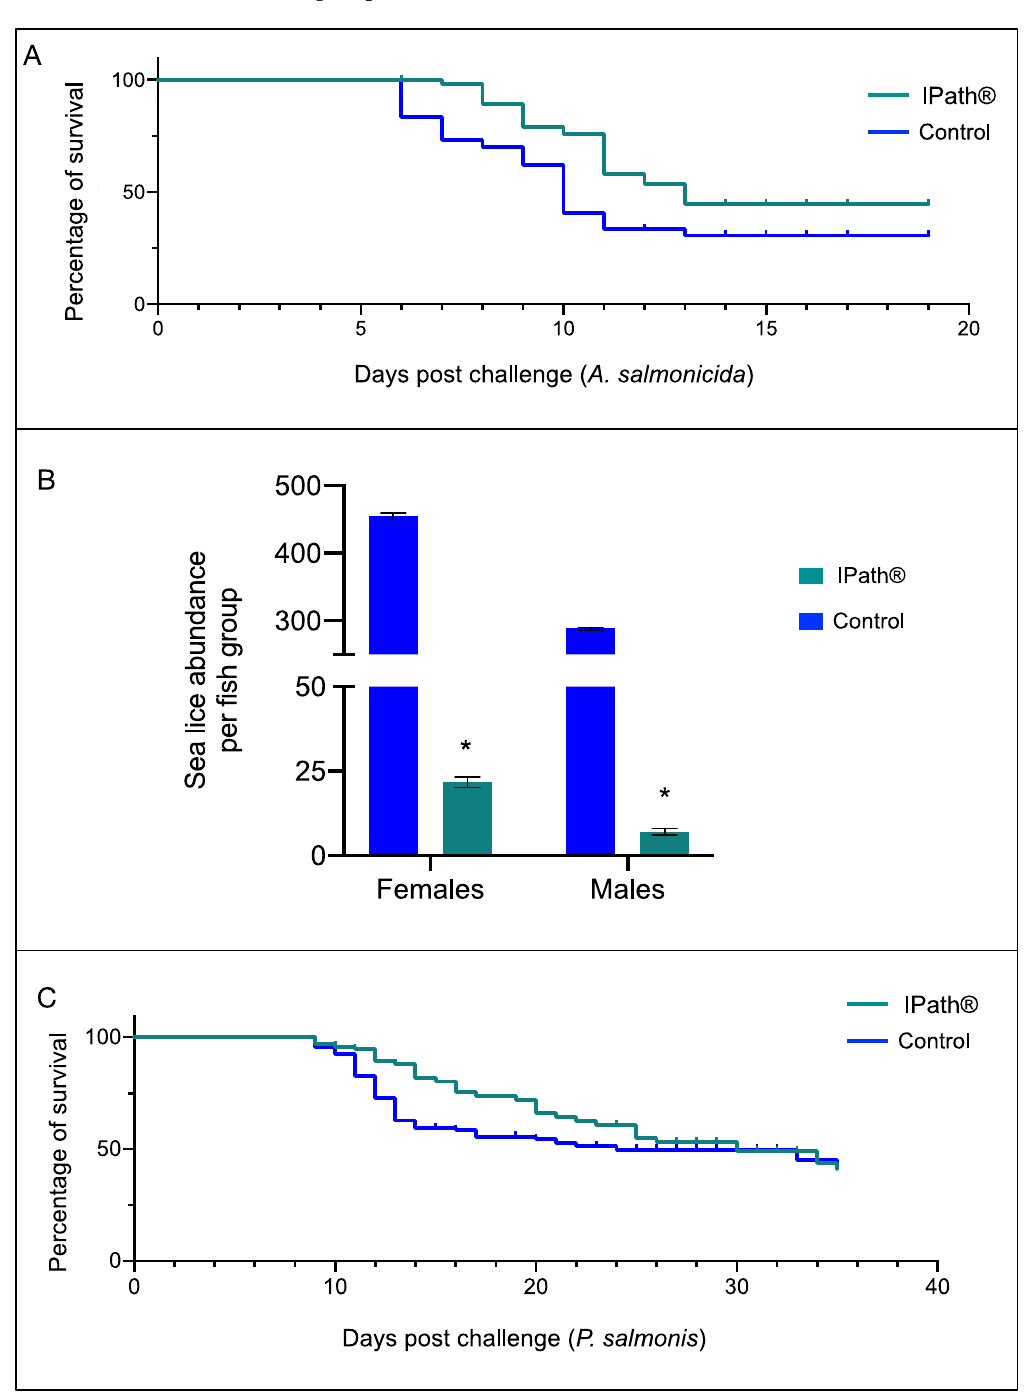
Figure 4. Survival and sea lice burden in Atlantic salmon vaccinated with IPath ® . ( A ) Probability of Atlantic salmon survival on Aeromonas salmonicida infection. ( B ) Caligus rogercresseyi abundance per fish group. * Indicates significant differences between IPath ® -vaccinated fish and the control group ( p < 0.005). ( C ) Probability of Atlantic salmon survival on P. salmonis